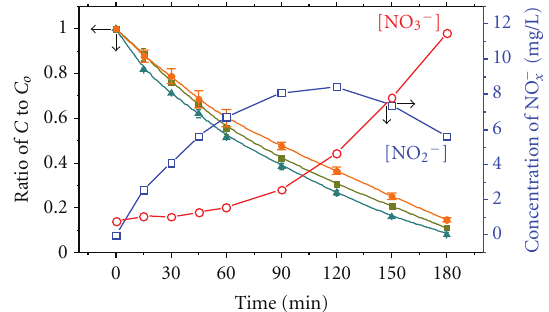
Figure 2: UV photocatalytic degradation of nitrobenzene at pH 4 (blue line with square symbols), 7 (green line with triangle sym- bols), and 11 (orange line with round symbols) with 0.2 g TiO 2 at 30 ◦ C and the air feeding of 150 mLmin − 1 for 3h. Concentrations of reaction intermediates nitrate (red line with empty circles) and nitrite ions (blue line with empty squares) at pH 7 are corresponded to the right ordinate as time changes.